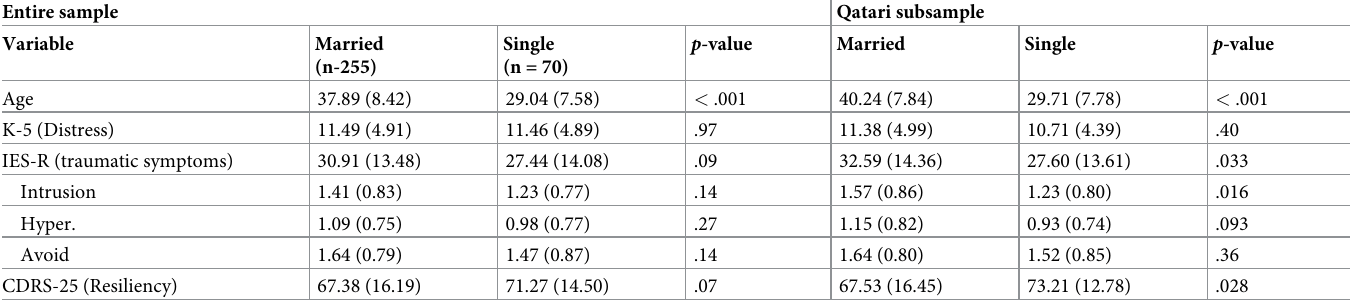
Table 6. Analysis of marital status for women for the entire sample and for Qatari subsample only (n = 278). Analysis of marital status for women for the entire sam- ple and Qatari subsample with sample size 278 showing prevalence of distress, traumatic symptoms, and resiliency. Entire